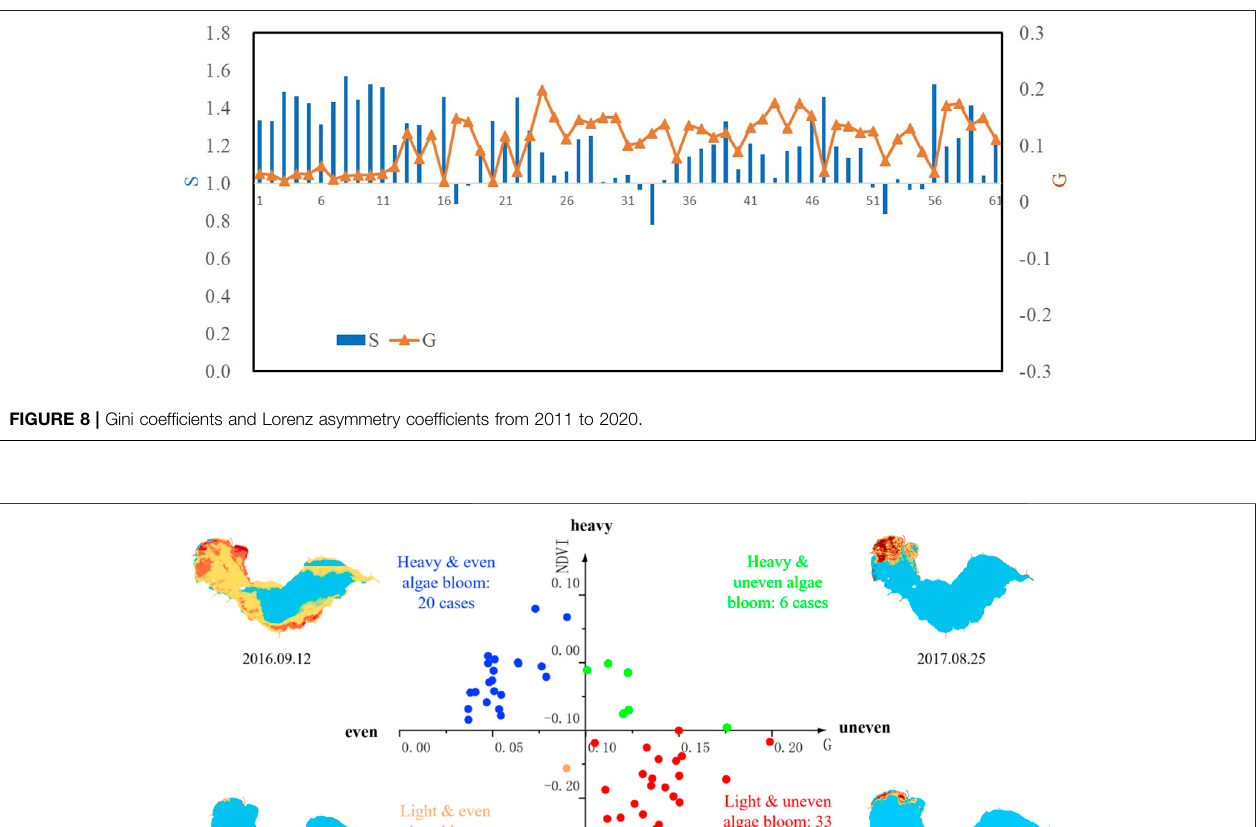
Frontiers in Environmental Science |